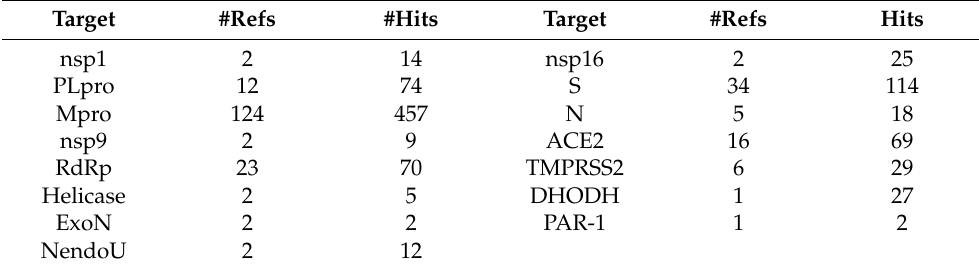
Table 2. Statistics of studies on the SARS-CoV-2 inhibitor discovery using